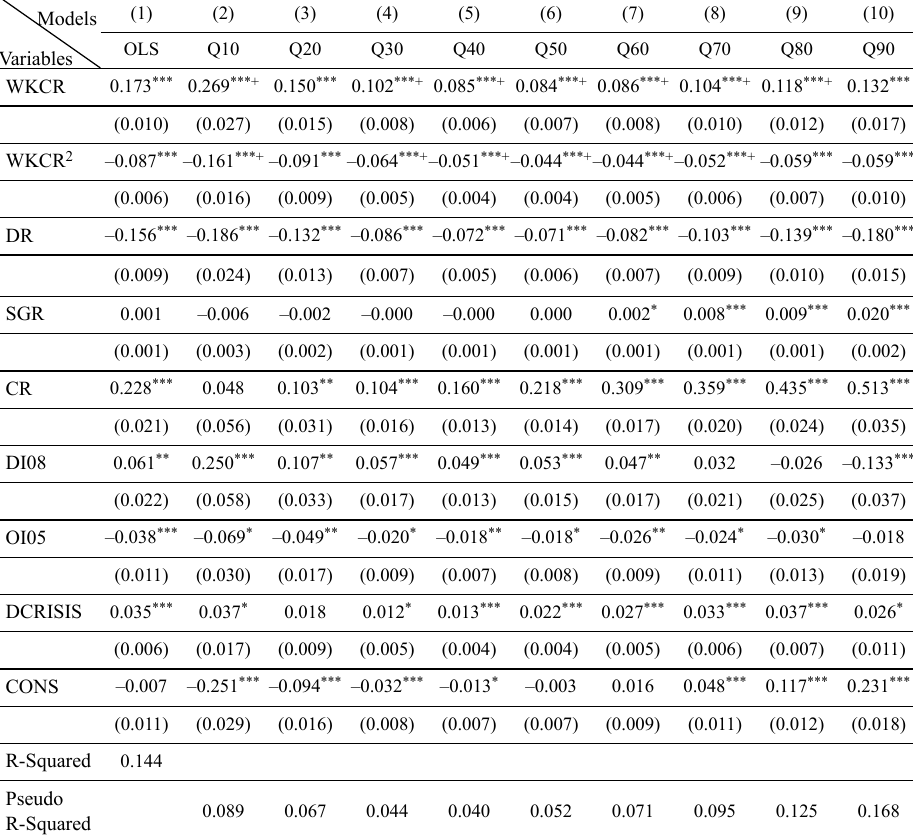
Table 5. Robustness check–coefficient estimates from quantile